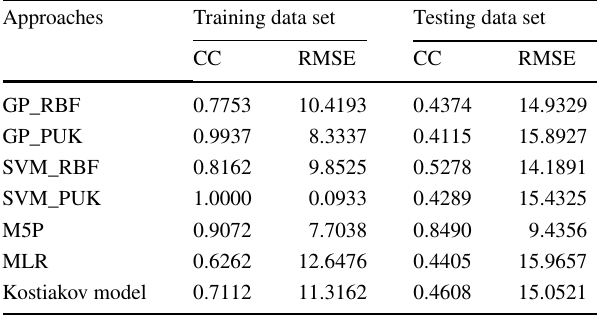
Table 5 Results of the different modelling approaches and empirical models for training and testing data set Approaches